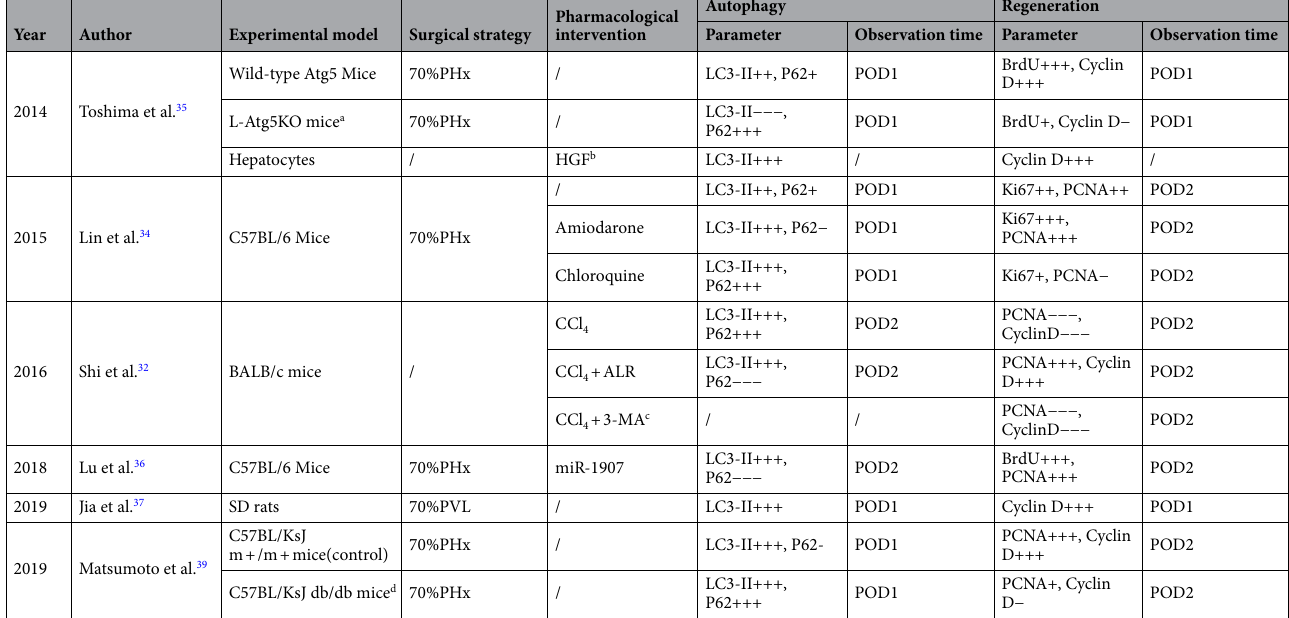
Table 2. Experimental studies investigating the protective role of autophagy during liver regeneration. a Atg5- deficient mice. b Hepatocyte growth factor. c 3-MA: 3-Methyladenine, autophagy inhibitor. d Model of liver steatosis and